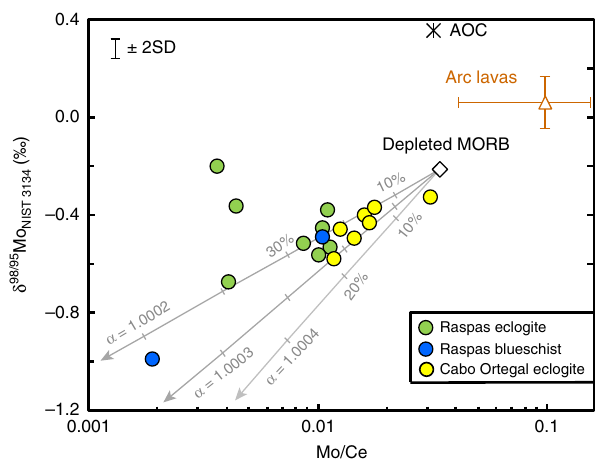
Fig. 2 Observed and modelled variations in Mo isotope compositions as a function of Mo/Ce. Grey lines are model δ 98/95 Mo NIST 3134 in residual oceanic crust following fractional loss of Mo-carrying fl uids using different fractionation factors ( α ) between fl uid and eclogite at 2.6 GPa, 600 °C and an oxygen fugacity of FMQ + 4 (see Methods). Tick marks denote 10% increments of fl uid loss by mass. We also plot reference values for: depleted mid-ocean ridge basalts (MORB) (ref. 21 ), altered oceanic crust (AOC) using the Super Composite composition from ODP Site 801 17 and fl uid-rich arc lavas 16 – 19,61 , selected with Ba/Th > 400 to minimise complexity of variable sediment contributions. The representative sample uncertainty is from replicate analyses of